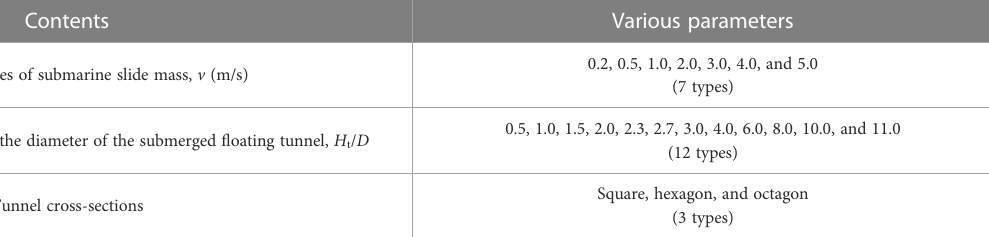
TABLE 1 Parameter settings of numerical